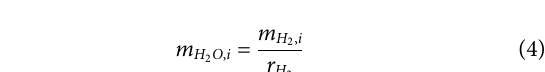
FIGURE 3 | Wind rose (A) and wind speed frequency distribution (B) at the Visby Airport on Gotland, Sweden.